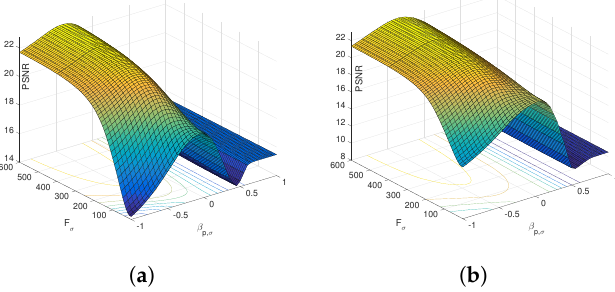
Figure 4. Dependency of the PSNR on F σ and β p , σ for test images contaminated with Gaussian σ = 30 and impulse p = 0.3. ( a ) Flower. ( b )